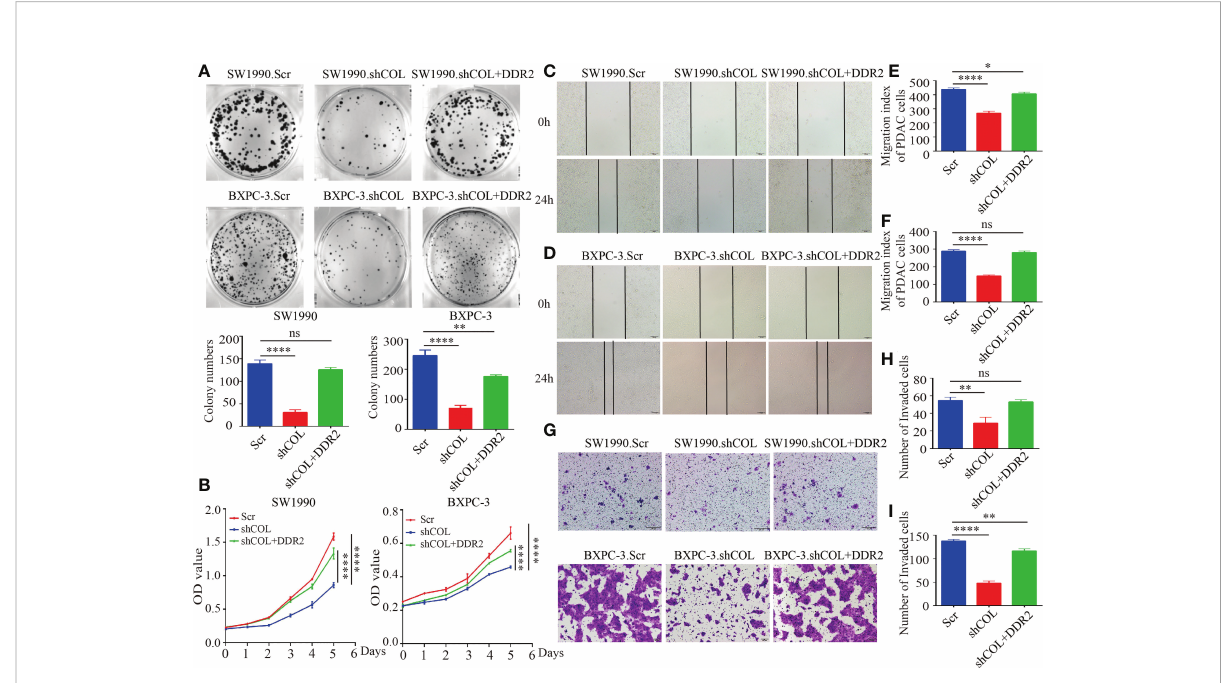
FIGURE 5 COL10A1 facilitates the malignant biological behavior of PDAC cells through DDR2. (A) Effect of DDR2 overexpression on the proliferative capacity of SW1990, BXPC cells after disruption of COL10A1 using clone formation assay. (B) Effects of shCOL and shCOL10A1+DDR2 on the proliferation ability of SW1990 and BXPC-3 cells by CCK8 assay. (C-F) Effects of shCOL and shCOL10A1+DDR2 on the migration ability of SW1990 and BXPC-3 cells by wound healing assays. Scale bar, 50 µm. (G-I) Effects of shCOL and shCOL10A1+DDR2 on the migration ability of SW1990 and BXPC-3 cells by transwell assays. Scale bar, 50 µm. * P < 0.05, ** P < 0.01, **** P < 0.0001. ns, no signi fi